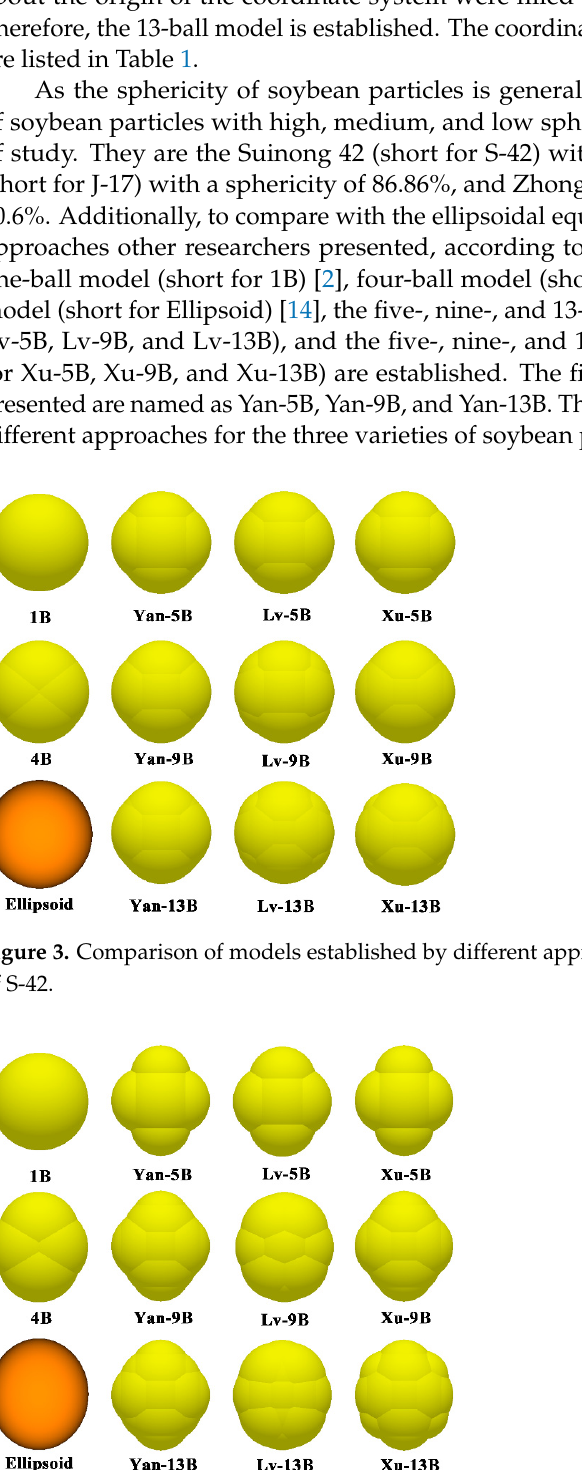
Figure 4. Comparison of models established by different approaches for one single soybean particle of J-17.